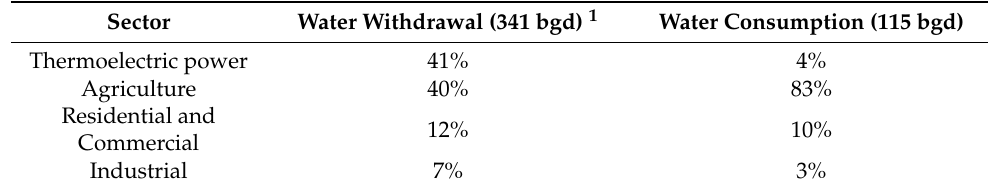
Table 4. Freshwater withdrawal and consumption in the U.S. in 2015 [64]. Sector Water Withdrawal (341 bgd) 1 Water Consumption (115 bgd) Thermoelectric power 41% 4% Agriculture 40% 83% Residential and 12% 10% Commercial Industrial 7% 3% 1 Billion gallons per